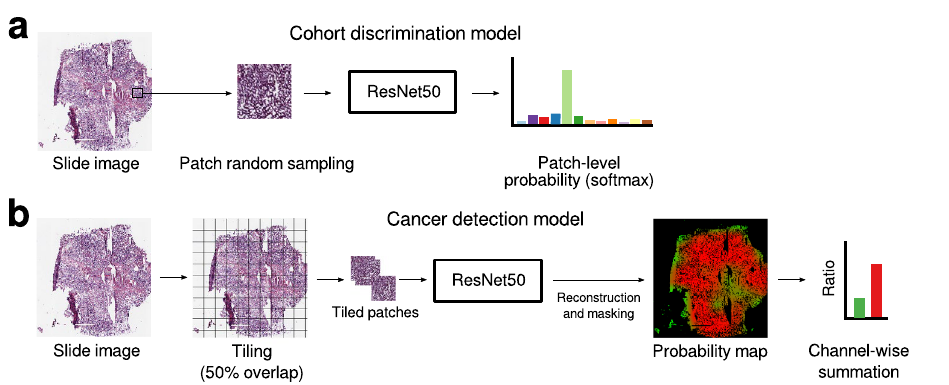
Figure 3. Input/output schematic of deep learning models. Cohort discrimination model ( a ) predicts which cohort a patch is drawn from. Cancer detection model ( b ) makes slide-level predictions determining whether the slide contains cancer or